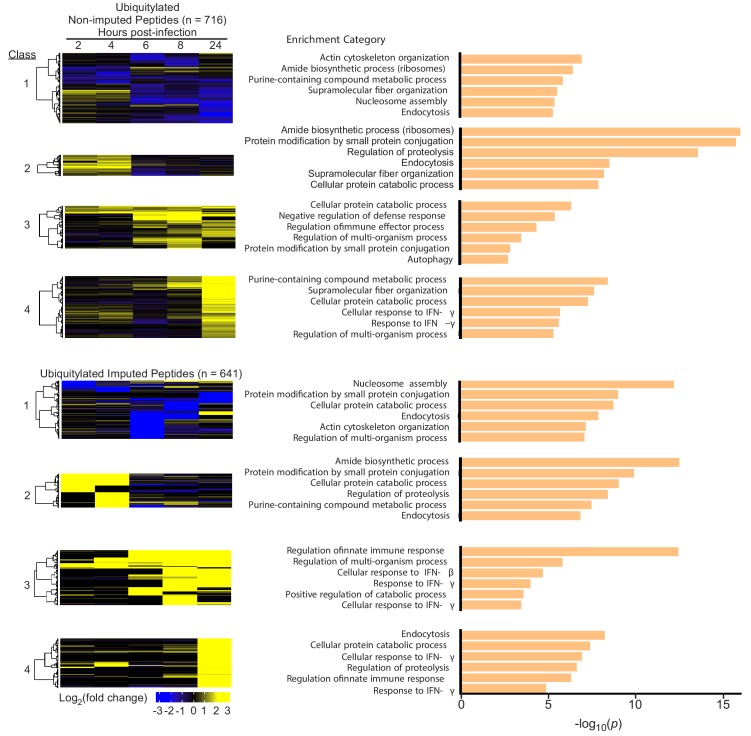
Changes in host protein ubiquitylation during Mtb infection.(A) Cluster analysis and heat map displaying the log2(fold change) in ubiquitylated peptide levels for non-imputed and imputed proteins with a p value less than 0.05. The most statistically significant functional enrichment term and representative proteins are indicated for each class of proteins. (B) Heat map visualization of functional enriched terms for each protein class.